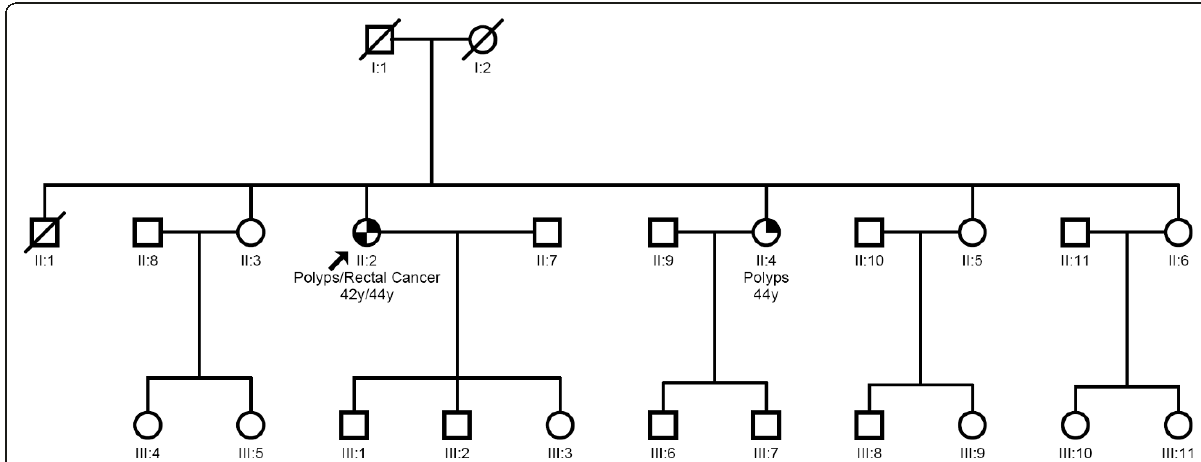
Figure 1 Family tree of patient FAP15 . The proband is indicated by the arrow. The proband ’ s age at onset of the polyposis (42 years) and of the rectal cancer (44 years) are indicated. The patient presented unaffected deceased parents, four unscreened (without colonoscopy) siblings and one affected sister. The affected sister presented with polyposis at the age of 44 years. The Caucasian patient stated having Portuguese great-grandparents and no report of inbreeding in her